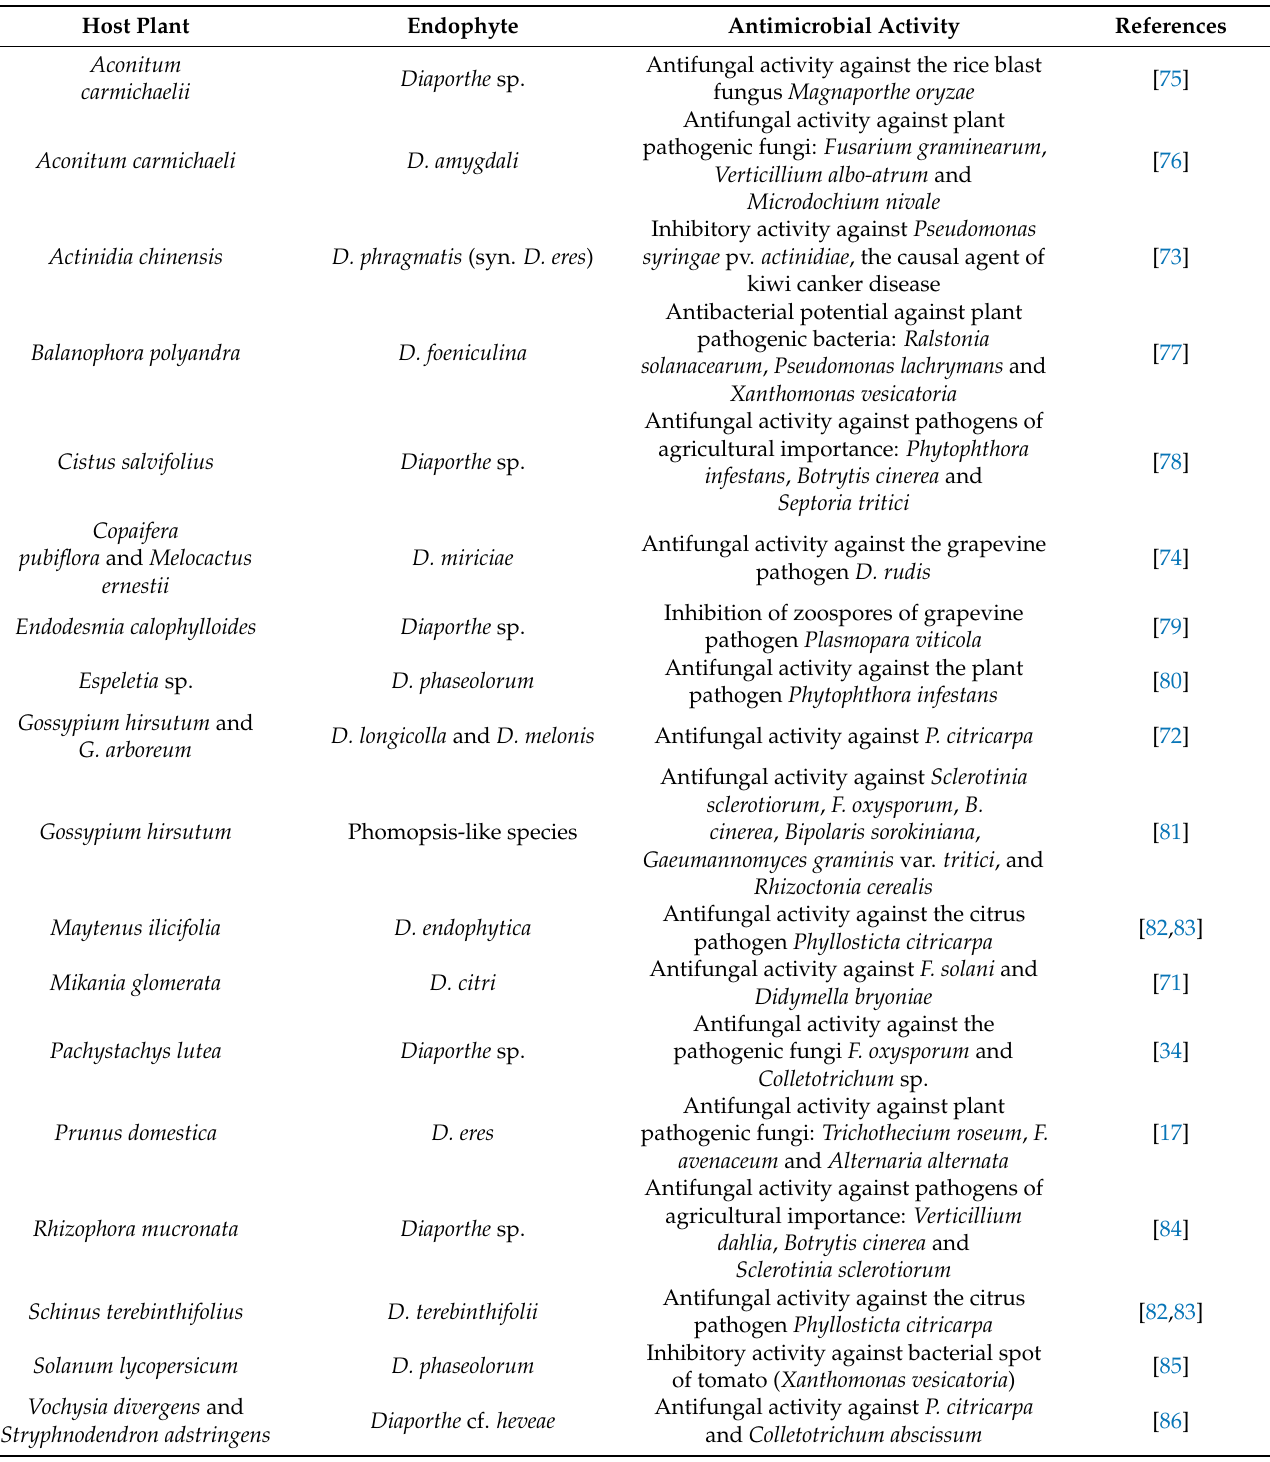
Table 1. Antimicrobial activity of Diaporthe against fungal and bacterial plant